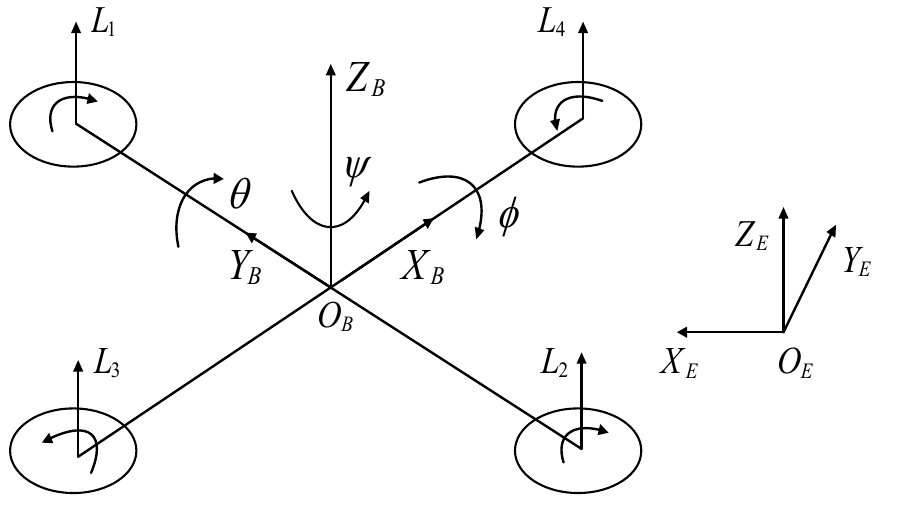
Figure 1. Structure diagram of a quadrotor.